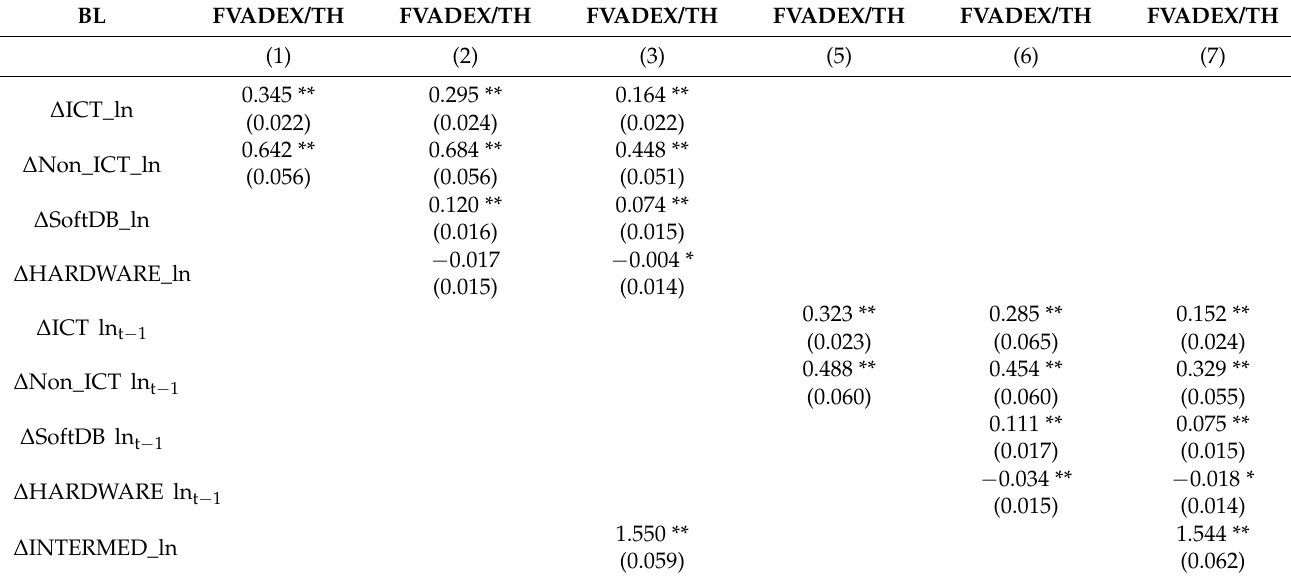
Table 5. Random effect panel regression results of the impact of ICT assets on backward linkages global value chains participation. The level of statistical significance is indicated as follows